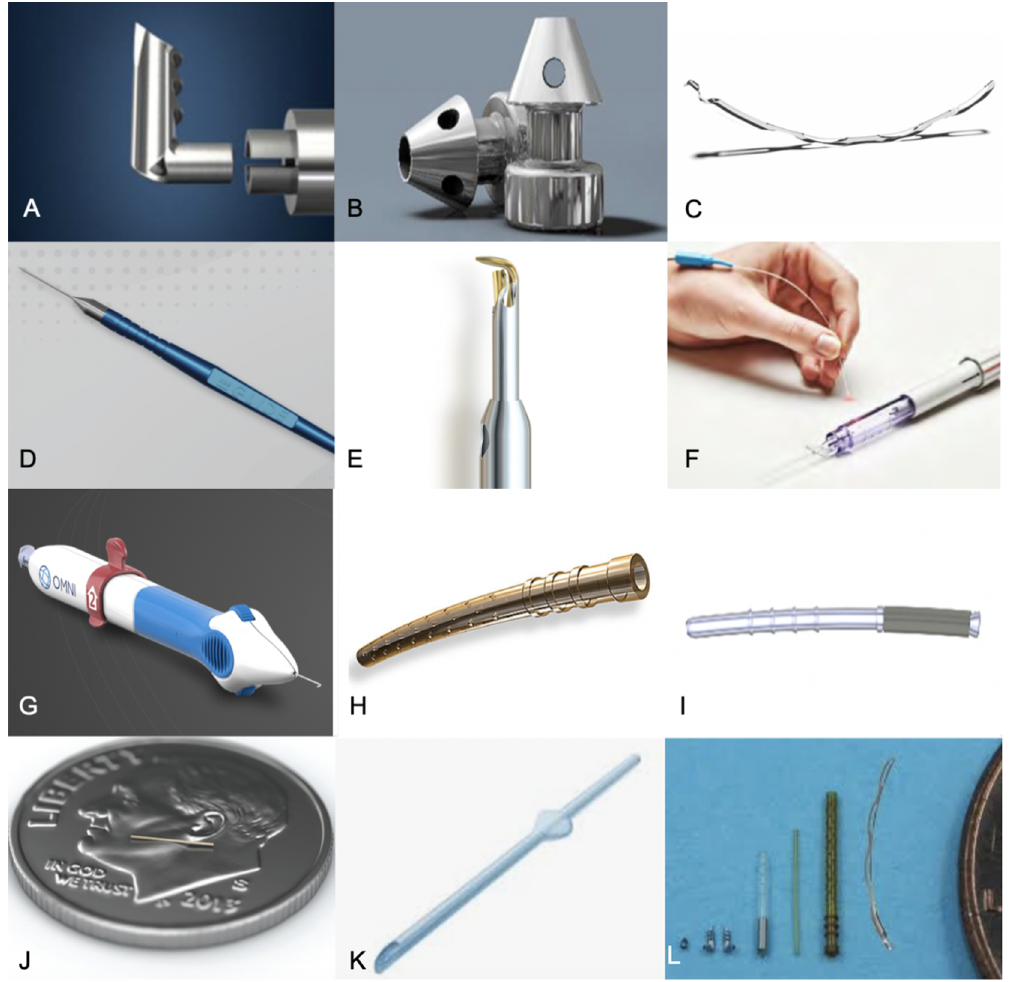
Figure 2. (A ). iStent, ( B ). iStent Inject, ( C ). Hydrus Microstent, ( D ). Kahook Dual Blade goniotome, ( E ). Trabectome, ( F ). iTrack Microcatheter, ( G ). OMNI system, ( H ). CyPass Micro-Stent, ( I ). iStent Supra, ( J ). XEN Gel Stent, ( K ). PreserFlo MicroShunt, ( L ). Various stents arranged by size (images courtesy of Glaukos Corp, San Clemente, CA, USA.; Alcon Laboratories, Fort Worth, TX, USA; New